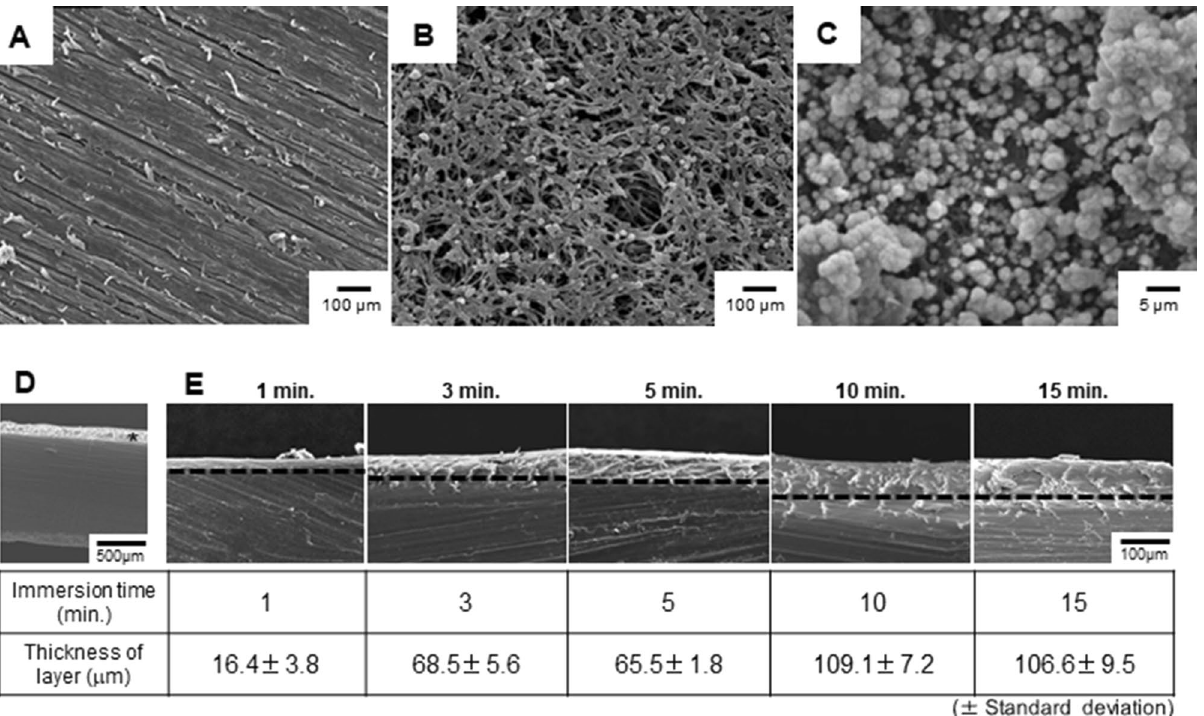
Figure 1. SEM images of untreated and H 2 SO 4 -treated PEEK and of PEEK-Ag + . The surface of pure polyetheretherketone (PEEK) ( A ) was immersed in 98% concentrated sulfuric acid (H 2 SO 4 ) for 10 min ( B ), after which a porous configuration was observed on the surface by SEM. Hydroxyapatite (HAp) aggregates were homogeneously coated on the PEEK coated with immobilized Ag + ions (PEEK-Ag + ) ( C ). The H 2 SO 4 modification of the PEEK surface was performed for different periods of time. Vertical sections of the PEEK plates are shown in ( D ) and ( E ). Asterisk reveals the reaction layer caused by H 2 SO 4 treatment. After 10 min of treatment in a 100-µm depth, the thickness of the modification stayed about the